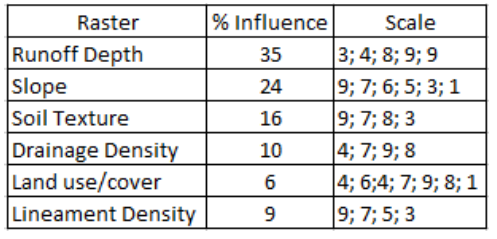
Table 1. Weighted overlay analysis and % influence of parameters by Mugo et al. (2019)